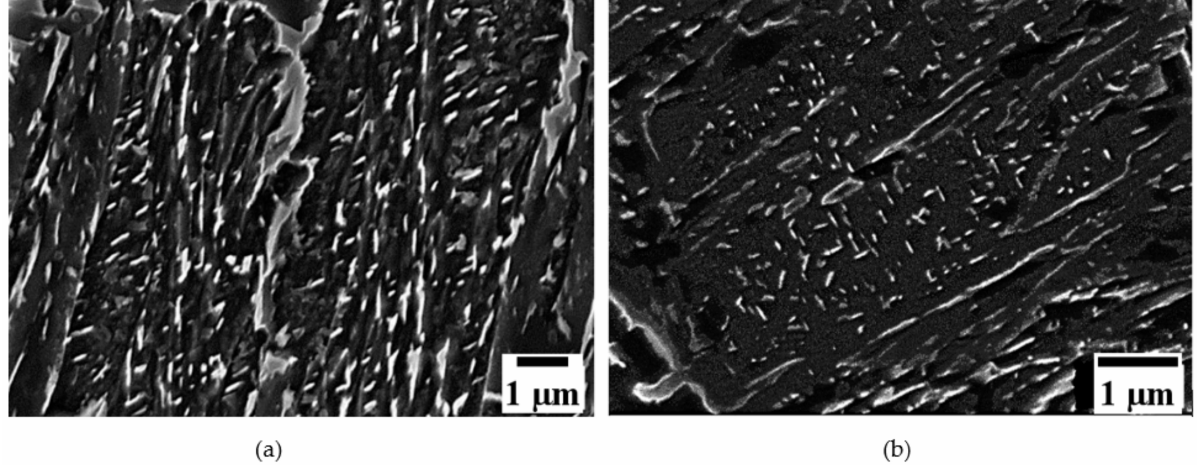
Figure 4. SEM micrographs of thermomechanically-processed steel 16 CrMnV7 7: ( a ) lower bainite with cementite platelets, and ( b ) self-tempered martensitic microstructure with homogeneously distributed small cementite